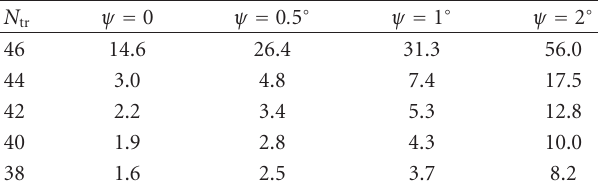
Table 3: Condition number of M obtained with Hertzian p .